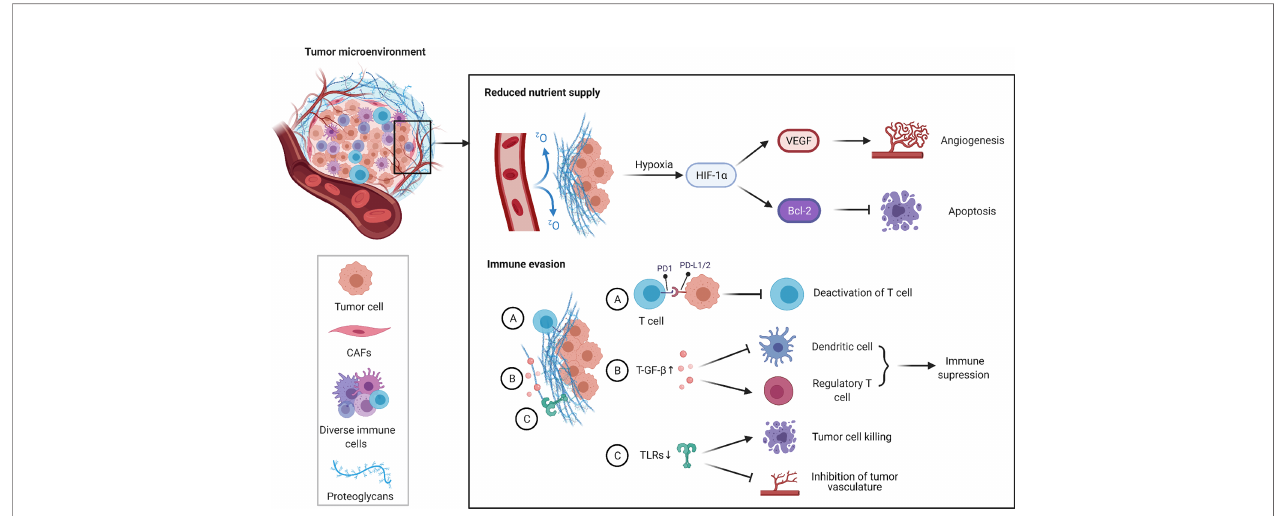
FIGURE 3 | TME and cisplatin resistance in OSCC. TME is typically characterized by hypoxia and immunosuppression. Hypoxia induces HIF-1 a -mediated signaling cascades, including induction of VEGF expression to promote tumor angiogenesis in hypoxic conditions and inhibition of apoptosis by regulating the expression of Bcl-2 anti-apoptotic family. In addition, a large number of cellular factors released by cancer cells and various bystander cells cause immune evasion by regulating the production and function of immune cells. Overall, the above pathways contribute to the cisplatin resistance of